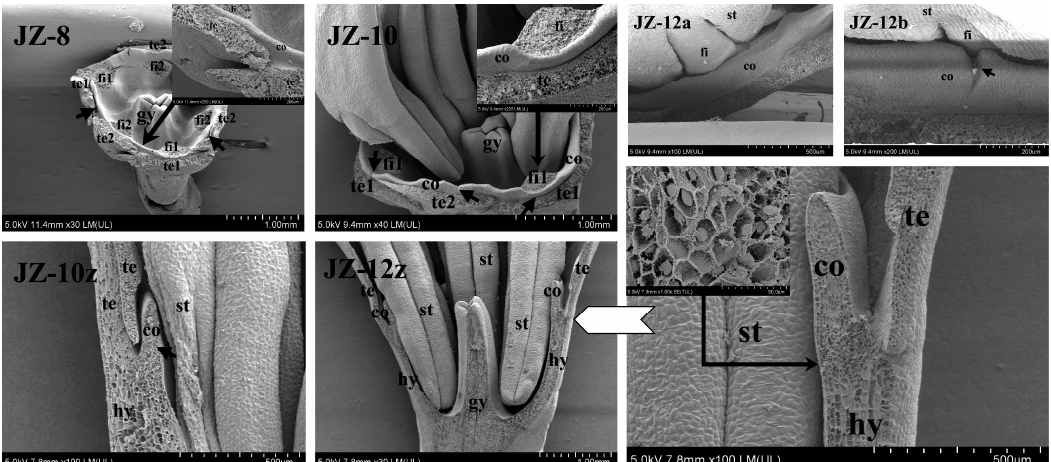
Figure 5. Scanning electron microscopic images of the JZ corona during morphogenesis. hy—hy- panthium; gy—gynoecium; te—tepal; st—stamen; co—corona; fi—filament. JZ-8 represents all te- pals and stamens stripped for JZ in period 8; JZ-10 represents all tepals stripped for JZ in period 10; JZ-10z and JZ-12z represent longitudinal sections for JZ in periods 10 and 12, respectively; JZ-12a